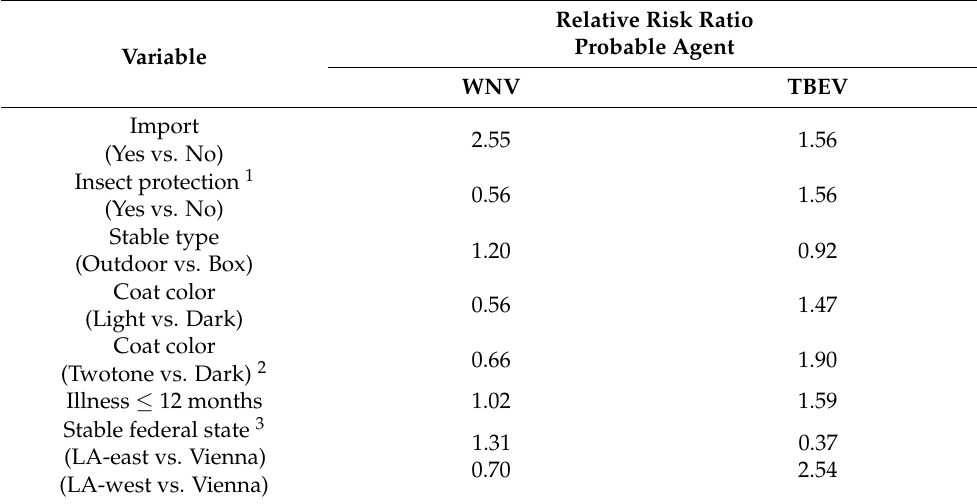
Table 2. Relative risk ratios for selected variables. Variables with values greater than one indi- cate positive association with WNV or TBEV infections, respectively. For instance, for imported horses the relative risk for WNV infection increases by a factor of 2.55. However, all variables were